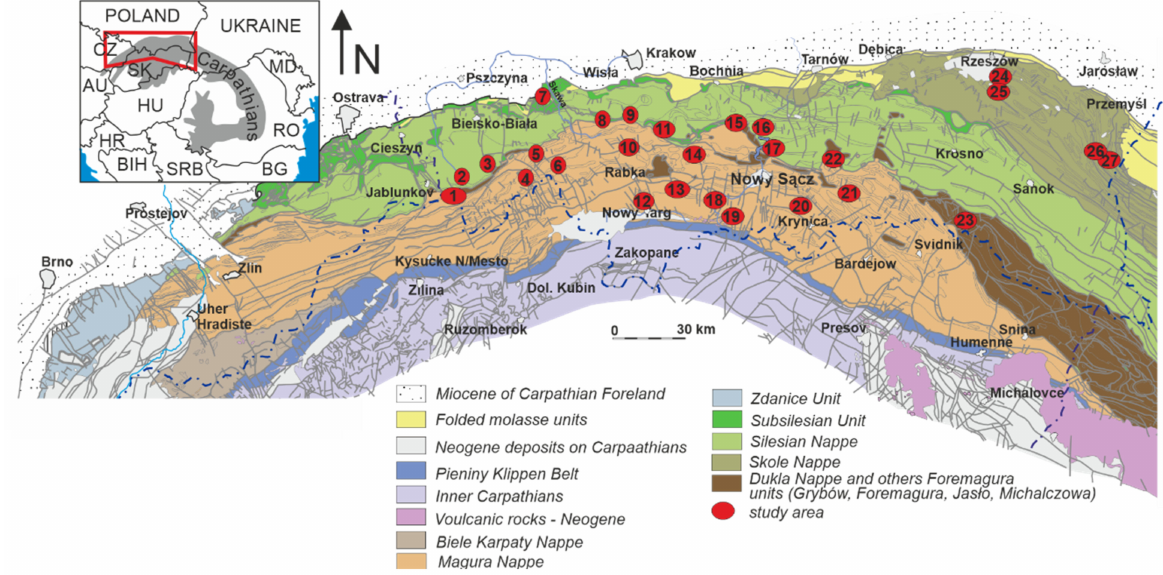
Figure 2. Location of the studied sections on the general geological map of the Western Carpathians (map on the